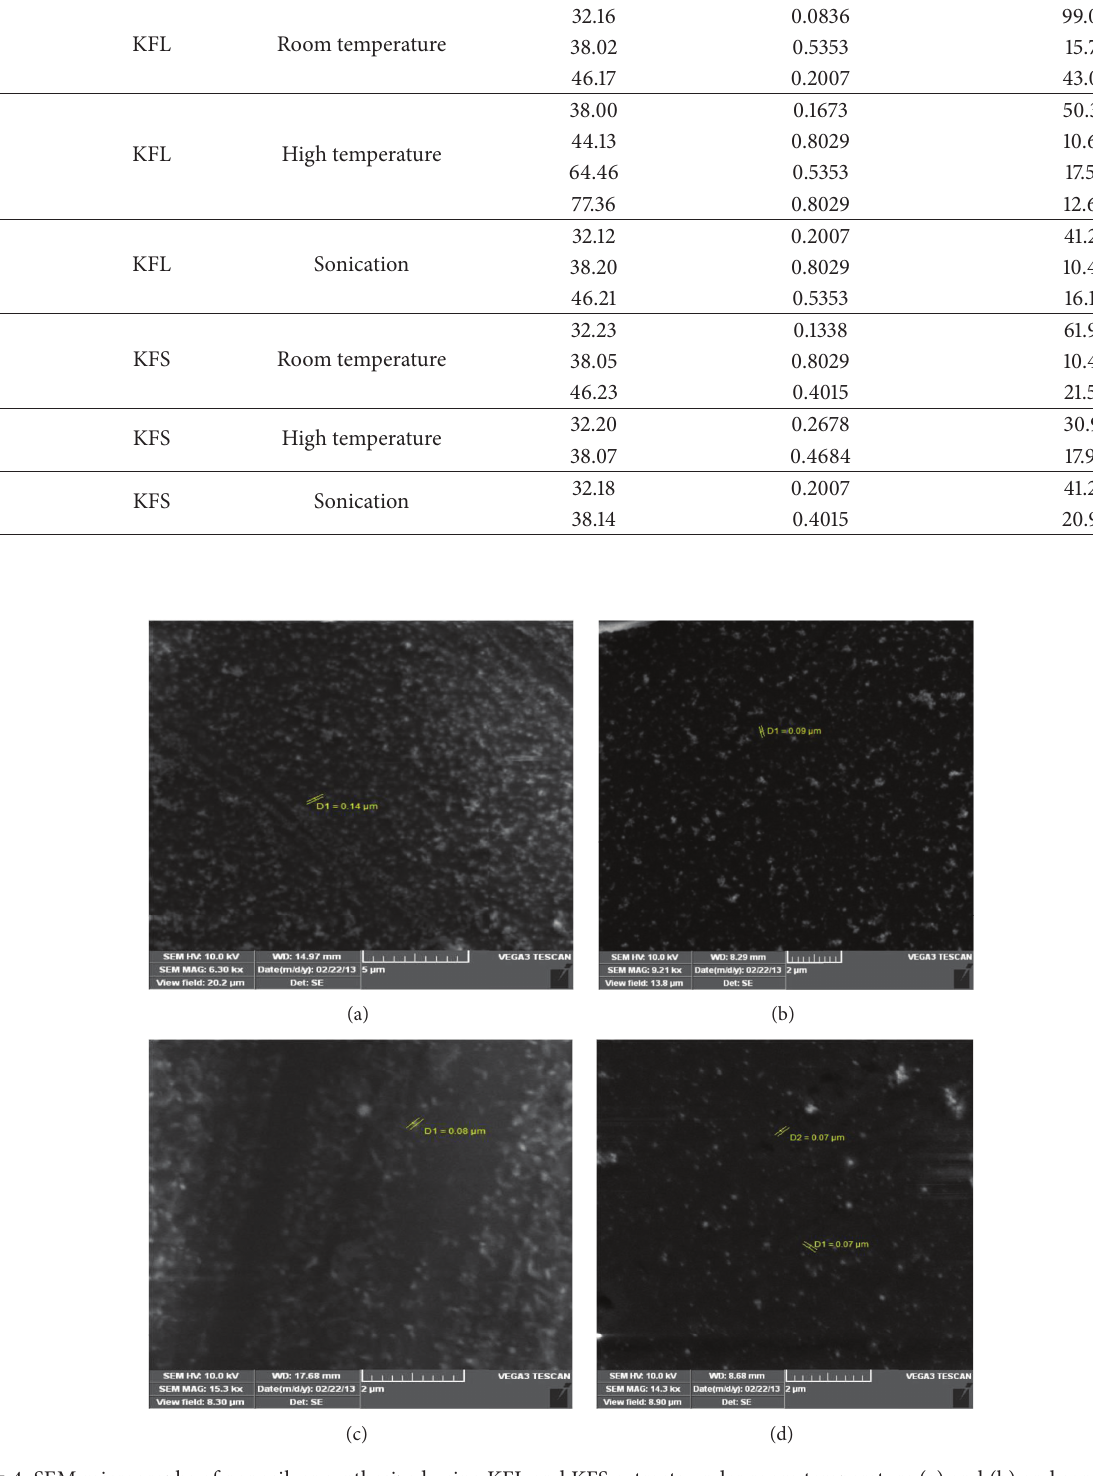
Table 1: Determination of particle size of nanosilver using Debye-Scherrer’s equation. S. number